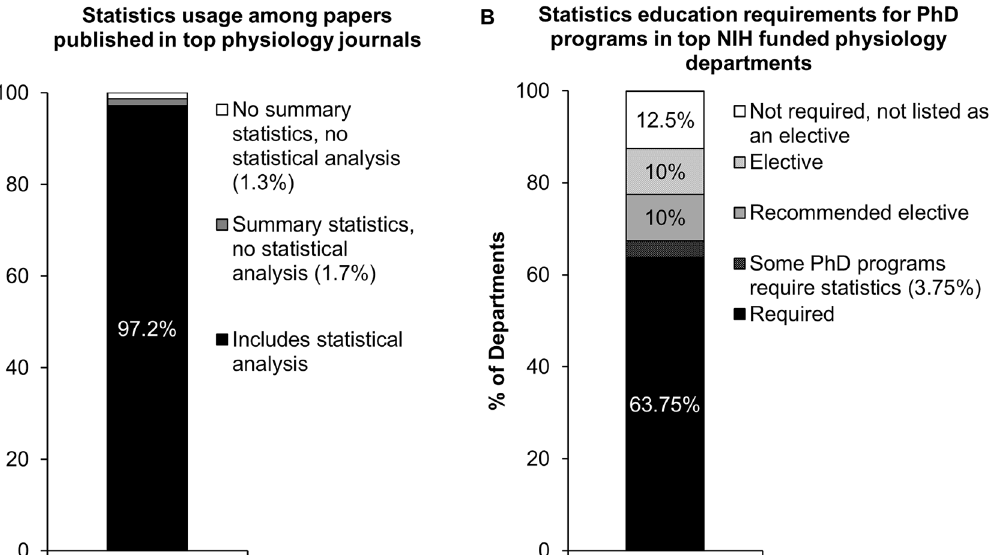
Fig 1. Statistics usage and education in physiology. A: A recent systematic review [4] demonstrated that 97.2% of papers published in the top 25% of physiology journals included statistical analyses. B: Statistics courses are not always required for PhD students in top NIH funded physiology departments. Detailed methodology for panels A and B are described in S1